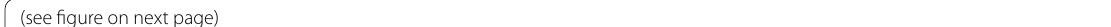
Fig. 3 A 44-year-old female presented with left breast upper outer quadrant mass. Pre-therapy : a The left breast showed a sizable partly spiculated solid mass at the upper outer quadrant that displayed rim enhancement in the post-contrast MR images. It was seen closely adherent and infiltrating the overlying skin along the outer aspect of the breast. Kinetic curve showed maximum relative enhancement of 134% and type III early washout curve pattern. b DWI showed restricted diffusion and a low ADC value of 0.767 10 − 3 mm 2 /s. c MRS was positive for choline × (choline peak 1.0 mmol/l). Histopathology : Invasive ductal carcinoma, grade II. Immunohistopathology : ER (4/8) and PR (8/8), negative for HER 2 = NEU and Ki 67 30%. Treatment decision : Neo-adjuvant chemotherapy and breast conservative surgery. Post-therapy : d The lesion showed delayed peak of contrast uptake at 448 s with corresponding signal intensity percentage of 109% and benign type curve pattern. e DWI showed restricted diffusion and displayed also low ADC value of 0.830 10 − 3 mm 2 /s. f Choline peak on the MRS images was still positive of estimated height value of × 0.9 mmol/l. Pathology report of surgical specimen : A whitish gritty irregular mass reaching the skin surface that measured 3.2 cm along its maximal diameter with picture of invasive duct carcinoma grade II and associated lobular features. Free surgical margins. One of the dissected lymph nodes showed metastatic deposits (1/5). Comments : Radiological and pathological non-responder. The case showed stationary size and the findings at the post-contrast series gave false impression of response. DWI and MRS showed malignant criteria and suggested the accurate diagnosis of a non-responder case that was proved by the pathology report